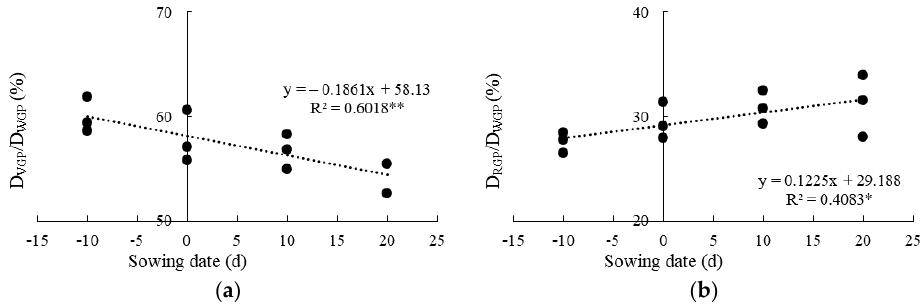
Figure 3. Effects of sowing date changes on the ratio of the vegetative growth period ( a ) and the reproductive growth period ( b ) of winter wheat. Note: D VGP denotes the length of the vegetative growth period, D WGP denotes the length of the whole growth period, D RGP denotes the length of the reproductive growth period. The black dotted line s represent the fitted regression trend line. The asterisks (* or **) indicate the trend’s significance at p < 0.01 (**) and p < 0.05 (*).